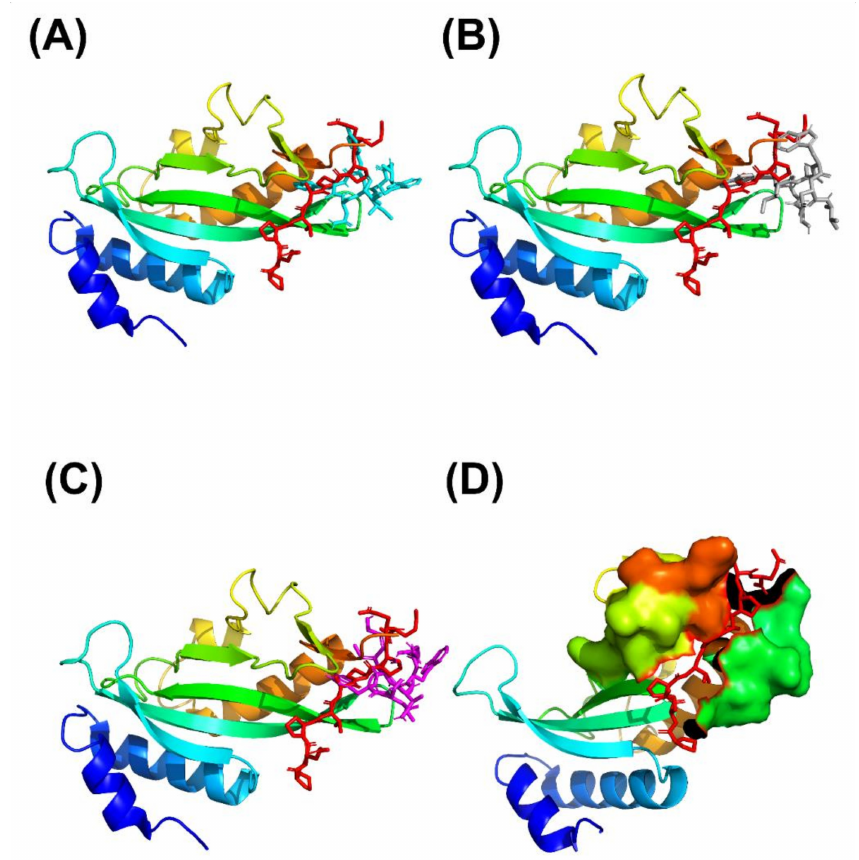
Figure 1. of the binding of UEV domain protein (ribbon model) with the native peptide shown as a stick model (red) and the three cyclic peptides shown as a stick model: ( A ) CP1 (cyan), ( B ) CP2 (gray), and ( C ) CP3 (magentas). (PDB ID: 3obu for the UEV domain protein with the native peptide) ( D ) The binding motif region of UEV domain protein (residue number: 61–66, 90–100 and 139–145) is shown as surface model, and the native peptide is shown as a stick model